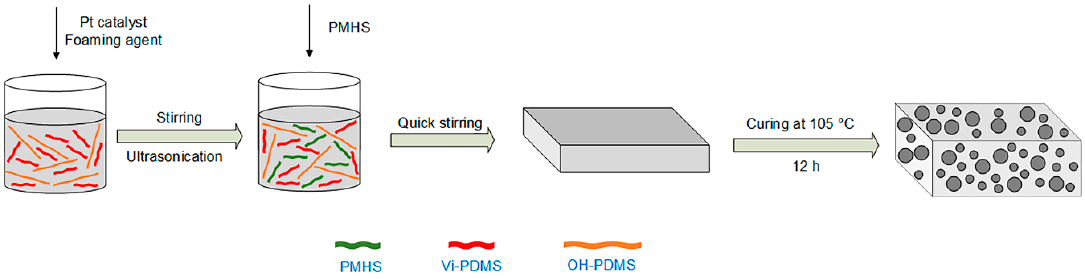
Figure 3. Flowchart for preparation of polysiloxane